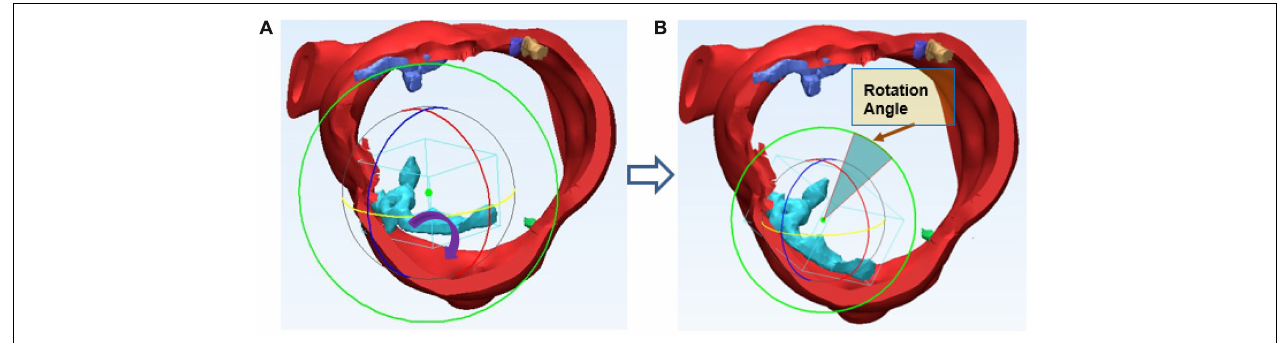
FIGURE 4 | Irregular calcium deposit rotation simulation. (A) preoperative; (B)